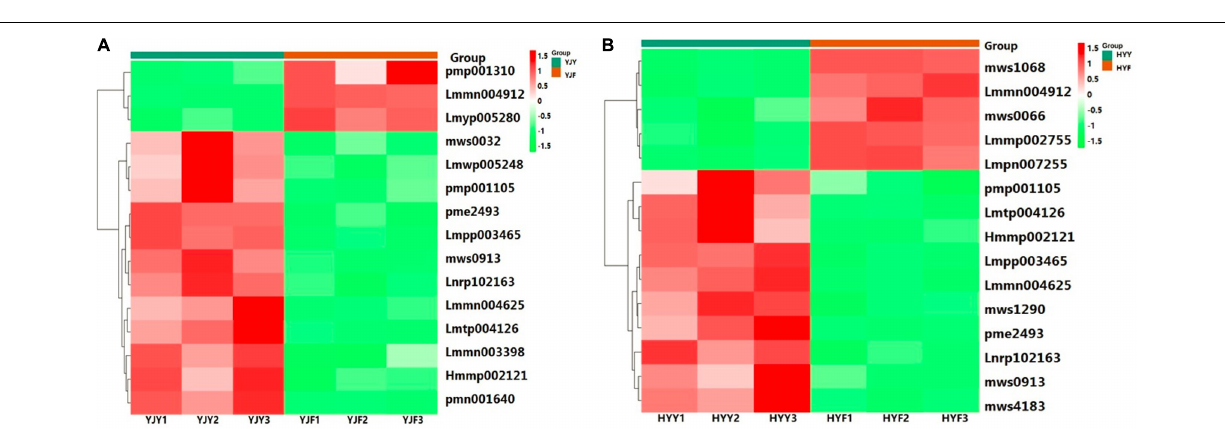
FIGURE 3 | Heat map of differential flavonol glycosides clusters in “Yinghong 9” and “Huangyu.” (A) Top 15 FC change flavonol glycosides between fresh leaves (YJY) and fermented leaves (YJF)of “Yinghong 9.” (B) Top 15 FC change flavonol glycosides between fresh leaves (YJY) and fermented leaves (YJF) of “Huangyu.” In the heatmap, differential flavonol glycosides marked with green and red were down- and upregulated in “Yinghong 9” or “Huangyu,” respectively. pmp001310,6-Hydroxykaempferol-3,6-O-Diglucoside; Lmmn004912,Quercetin-3-O-methyl ether; Lmyp005280, Isorhamnetin-3-O-[6 (cid:48)(cid:48) -p-coumarylglucosyl-O-rhamnoside; Lmmn003398, Kaempferol-3-O-(6 (cid:48)(cid:48) -acetyl)glucoside; Lmmn004625, Dihydrokaempferol-7-O-glucoside; Lmwp005248, Kaempferol-3-O-(6”’-p-Coumaroylglucosyl)-Glucoside-7-Rhamnoside; mws0913, Kaempferol-3-O-galactoside; mws0032, Myricetin; pmp001105, Kaempferol-3-O-neohesperidoside-7-O-glucoside; pme2493, Kaempferol-3,7-O-dirhamnoside; Lnrp102163, Quercetin-3-O-rutinoside-7-O-rhamnoside; Hmmp002121, Isorhamnetin-3-O-gallate Lmpp003465, Myricetin-3-O-glucoside; Lmtp004126, Myricetin-3-O-(6 (cid:48)(cid:48) -malony)glucoside; pmn001640, Myricetin-3-O-arabinoside. Lmmp002755, Quercetin-7-O-rutinoside-4’-O-glucoside; Lmpn007255, 6-Methoxyquercetin; mws0066, Isorhamnetin;